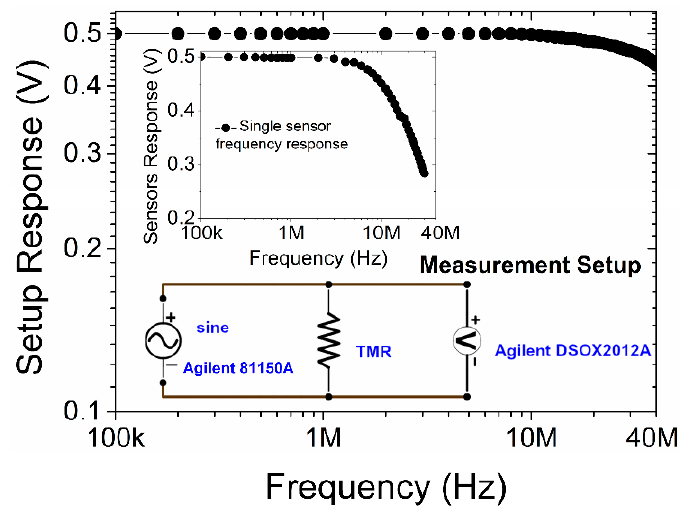
Figure 2. Bandwidth of the measurement system. Inset: Measurement system scheme and frequency response of a single sensor.